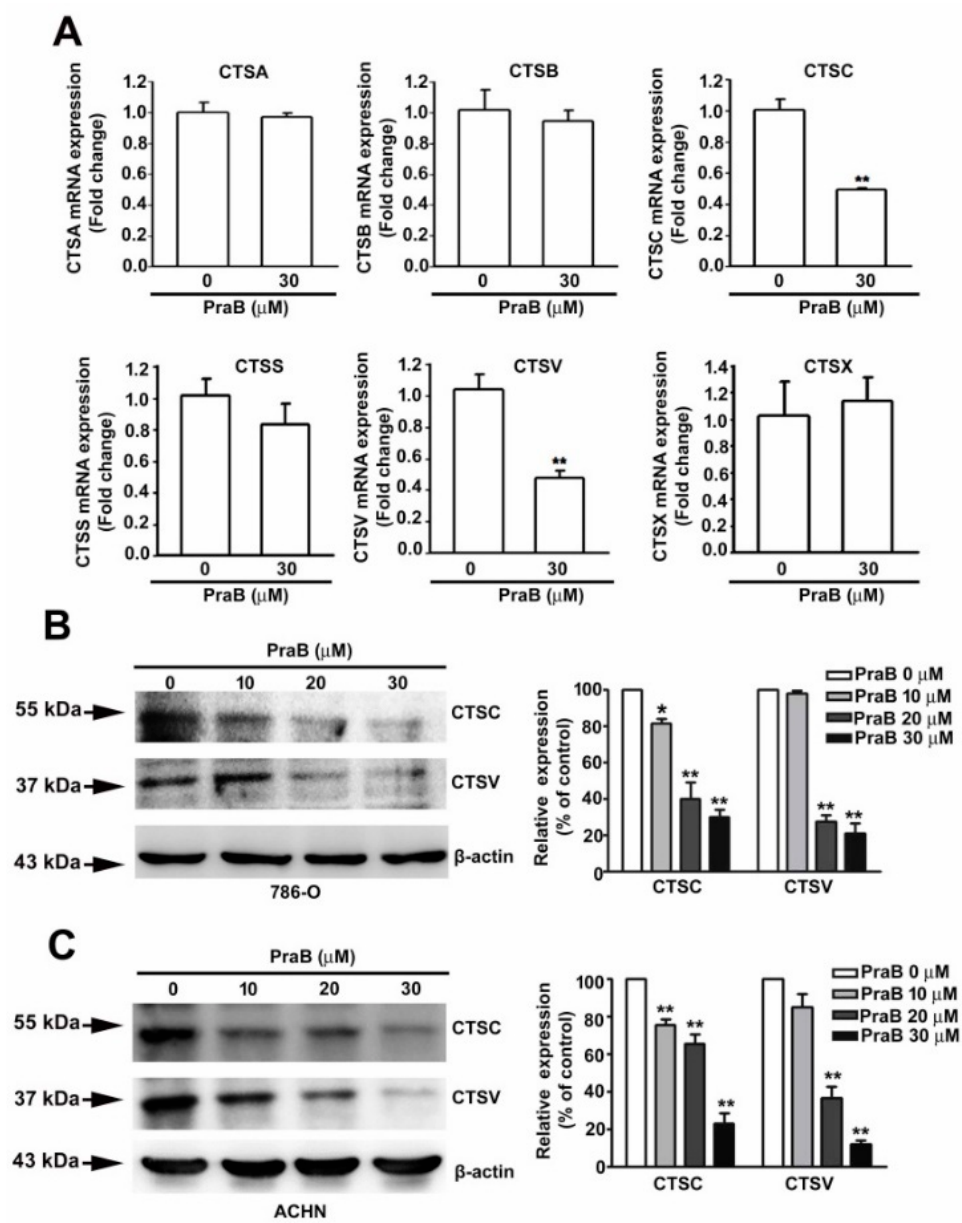
Figure 3. Inhibitory e ff ects of Pra-B on cathepsin C (CTSC) and cathepsin V (CTSV) expression in RCC cells. ( A ) 786-O cells were treated with Pra-B (0 and 30 µ M) for 24 h, after which the cells were harvested for the detection of CTS mRNA levels through quantitative real-time PCR. ( B , C ) 786-O and ACHN cells were treated with various concentrations of Pra-B (0, 10, 20, and 30 µ M) for 24 h, and protein levels were subsequently analyzed using immunoblotting. The histogram represents the densitometric analysis of CTSC and CTSV protein expression. β -actin was used as the loading control. * p < 0.05, ** p < 0.01 relative to the control. Data are presented in terms of mean ± SD, as determined in at least three independent experiments.